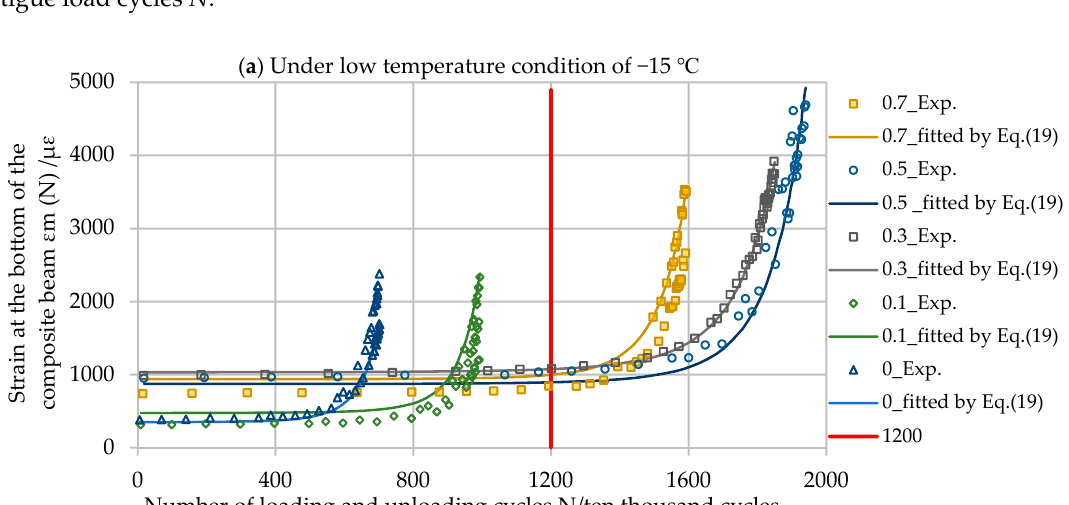
and the fatigue load cycles N .